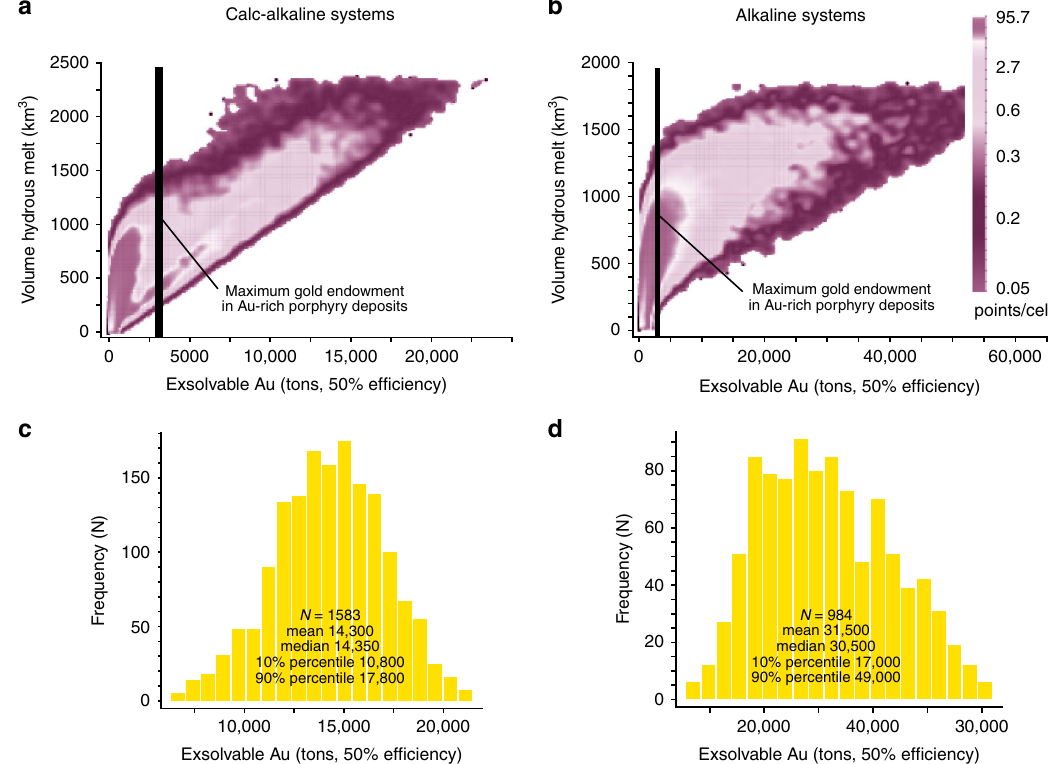
Fig. 2 Monte Carlo simulations of exsolvable gold and relationship to magma volumes. Density plots of the Monte Carlo simulations (>25,000) show that both calc-alkaline ( a ) and alkaline ( b ) magmatic systems can potentially exsolve fl uids, during the lifetimes of the porphyry deposits indicated by geochronology, carrying and precipitating (50% ef fi ciency) much larger amounts of gold than those recorded by the Au-richest porphyry deposits; c histogram of the exsolvable gold (50% ef fi ciency) for the magma volume range (1750 – 2250 km 3 ) associated with the largest Cu endowments (50% precipitation ef fi ciency) in calc-alkaline magmatic systems: this corresponds to the density distribution of exsolvable Au simulations for the volume interval 1750 – 2250 km 3 in ( a ); d histogram of exsolvable gold (50% ef fi ciency) for the largest magma volume range (1000 – 1500 km 3 ) obtained in the simulations for alkaline